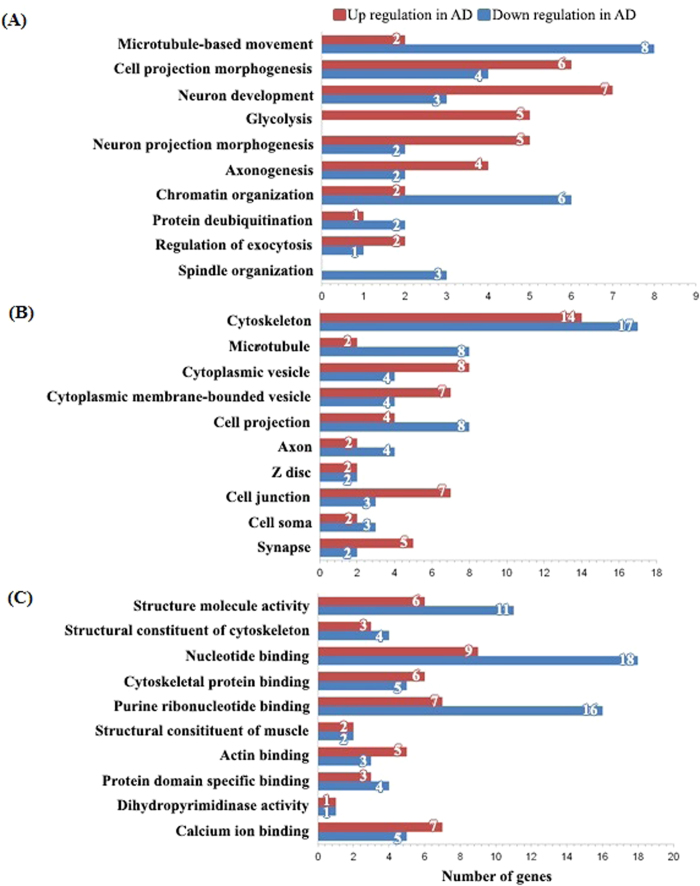
Analysis of regulated proteins using DAVID functional Gene Ontology.(A) Biological processes. (B) Cellular components. (C) Molecular functions (EASE score > 1.3, p < 0.05).